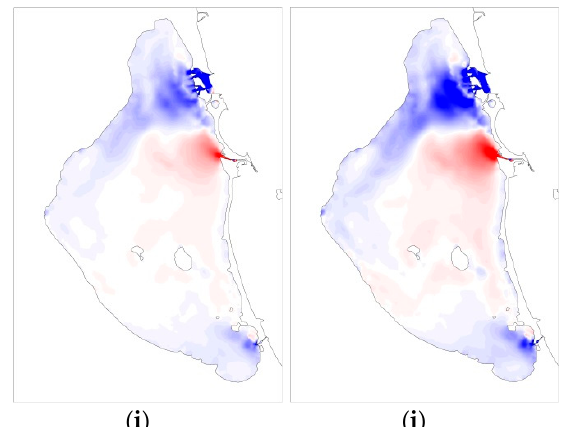
Figure 9. Current speed differences in spring: ( a ) Maint_Enc; ( b ) Mar_part_0.5m; ( c ) Mar_0.5m; ( d ) Maint_Enc_Mar_0.5m; ( e ) Enc_1m; ( f ) Enc_1.5m; ( g ) Mar_1m; ( h ) Mar_1.5m; ( i ) Enc_Mar_1m; ( j ) Enc_Mar_1.5m (Red: increase/Blue: decrease).